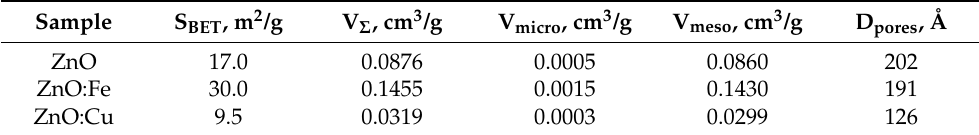
Table 1. Surface textural characteristics of the obtained nanopowders.